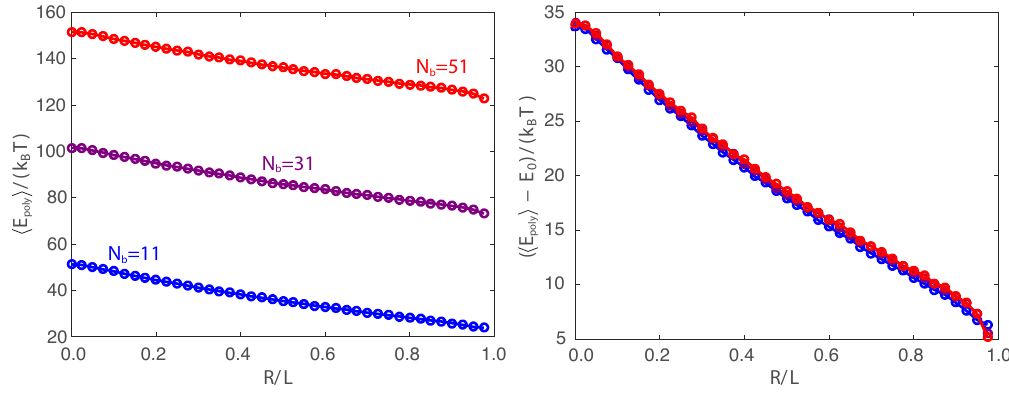
Figure A1. The left plot shows the average polymer energy (cid:104) E poly (cid:105) versus the end extension from Monte Carlo simulations for a chain of length L = l p /2 and number of beads N b = 11 (blue), N b = 31 (purple), and N b = 51 (red). The right plot demonstrates that subtracting the references’ energy E 0 = 5 k B T ( N b − 4 ) from each average polymer energy (cid:104) E poly (cid:105) gives an average polymer energy that 2 is invariant to the discretization and reflects the deformation energy of the fluctuating polymer chain under